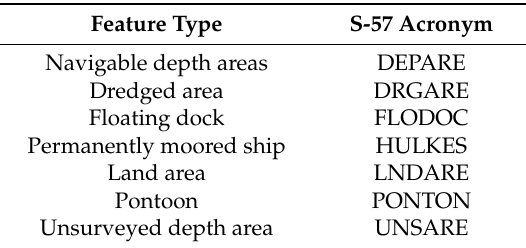
data coverage and thus does not represent a chart discrepancy. Table 3. The S-57 ENC area feature types, with the corresponding acronym, belonging to the restricted “skin of the earth” group.